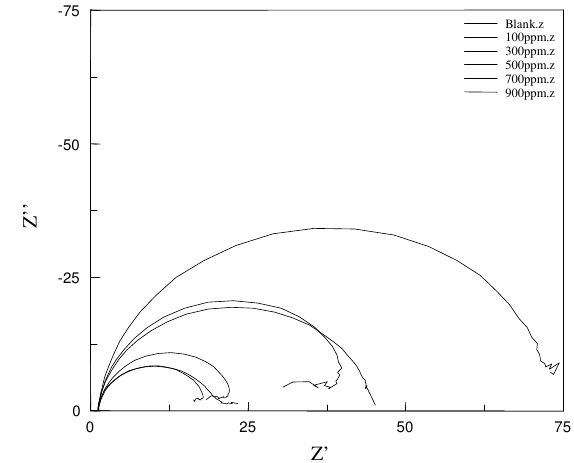
Figure 3. Nyquist Plot of MS in presence of